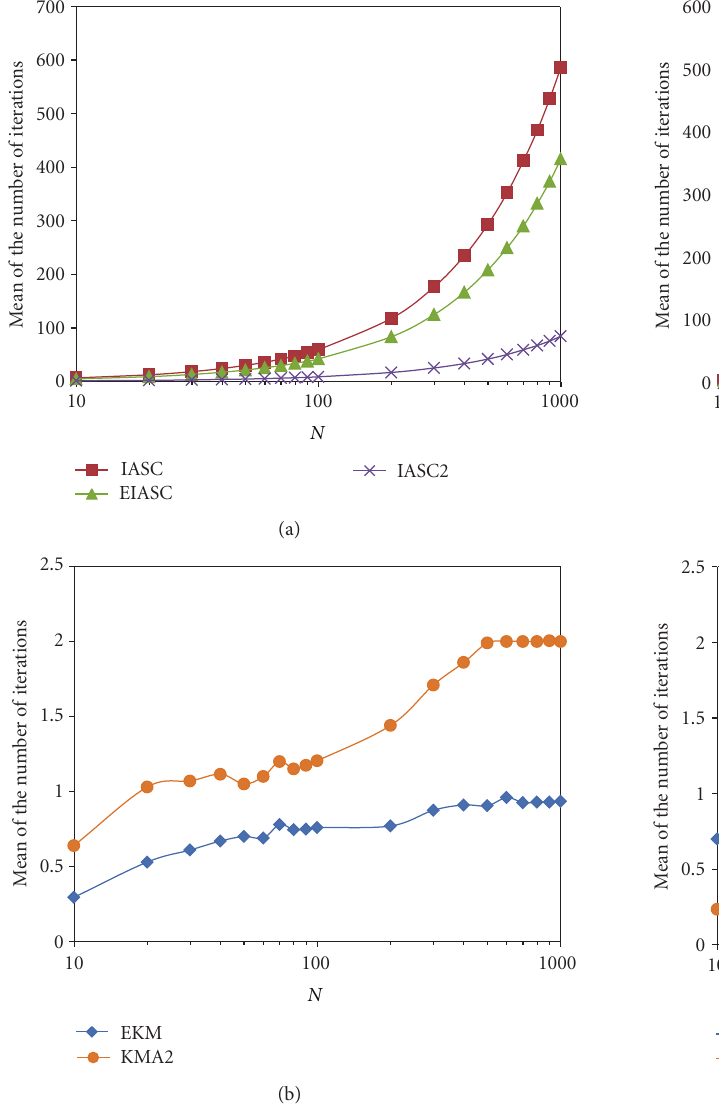
Figure 8: Centered random FOU, iterations: (a) IASC-type algo- rithms and (b) KM-type